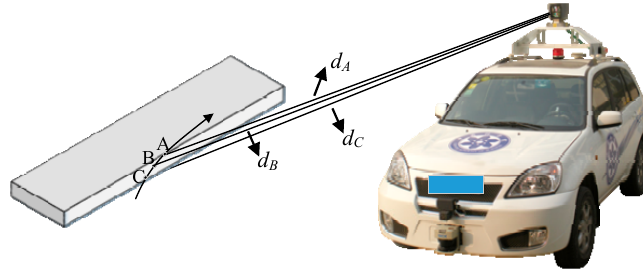
Figure 3. Schematic figure of obstacle scanning.